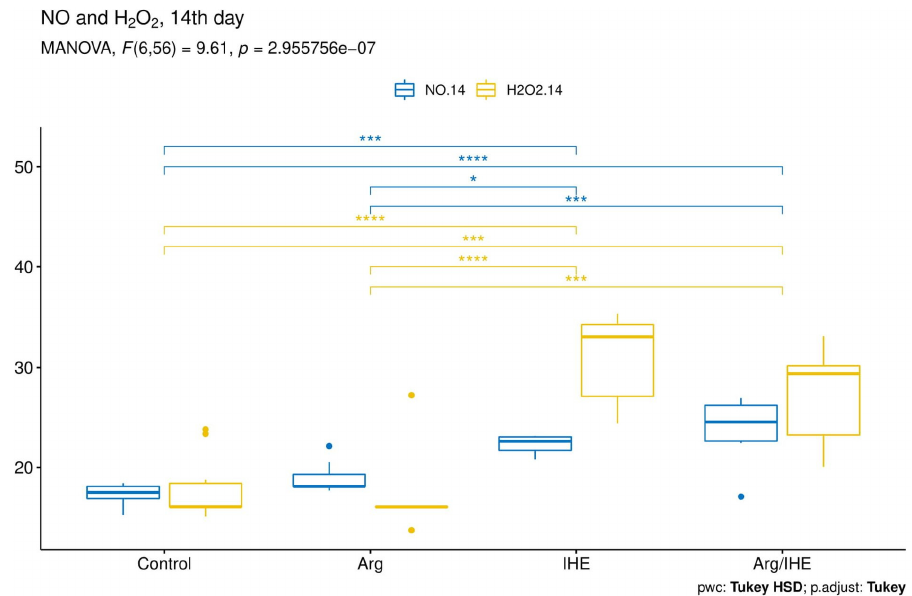
Figure 4. Visualisation of the MANOVA statistical analysis of changes in nitric oxide (NO) and